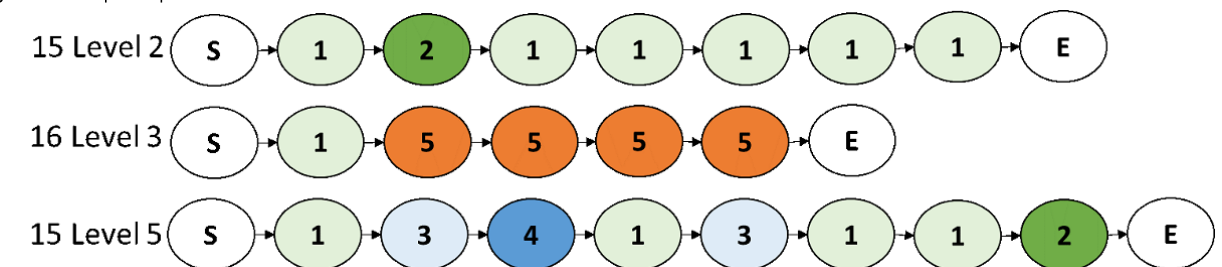
Figure 4. Sample